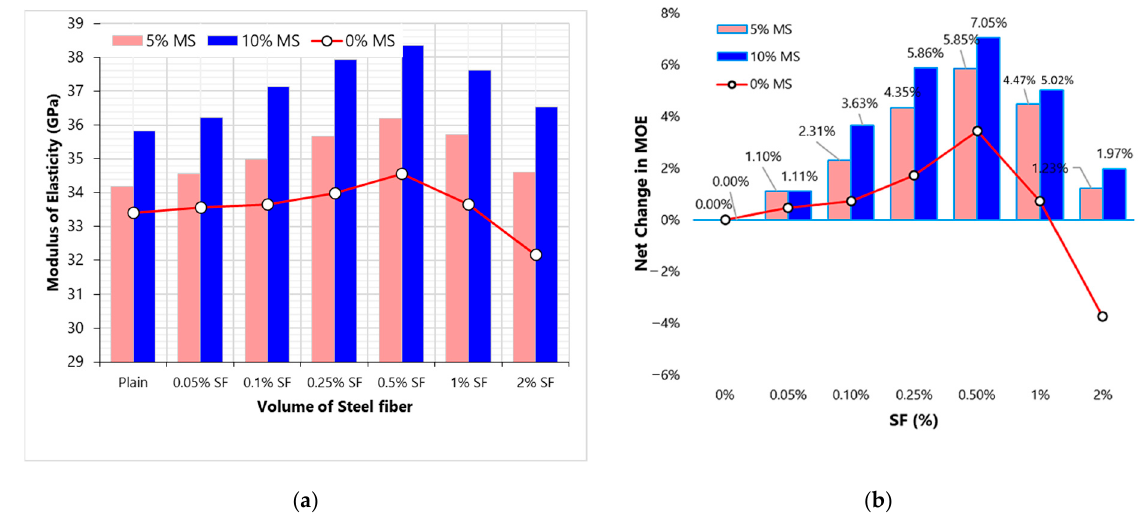
Figure 6. Modulus of elasticity (MOE) results ( a ) effect of MS on MOE with varying SF dosage ( b ) effect of MS on the net change in MOE with varying SF dosage.